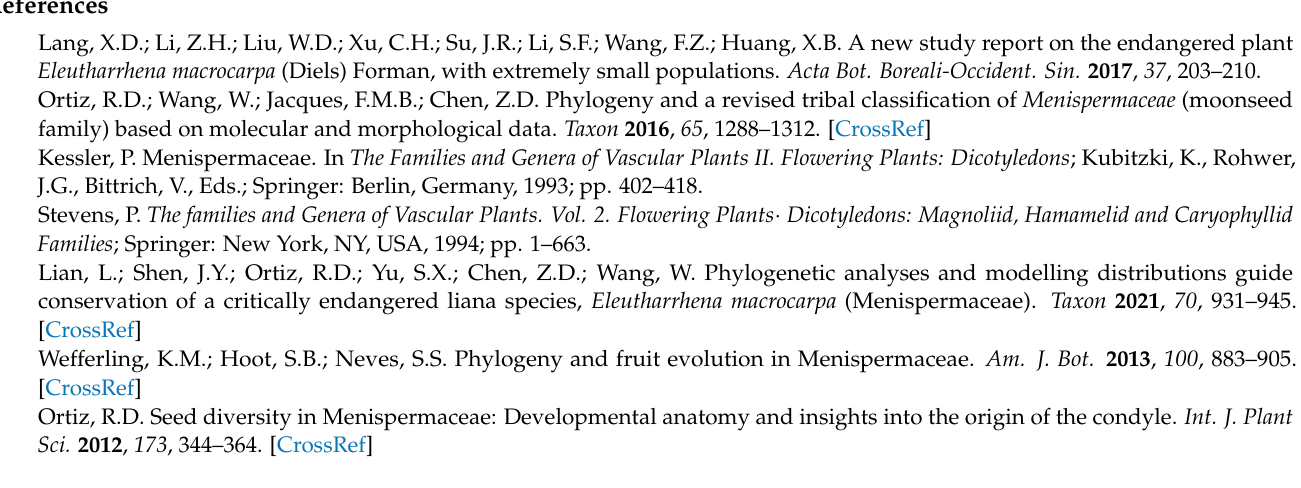
Figure A3. Mantel’s test between genetic distance and geographical distance correlation. Equation: Y = 0.0003 x + 0.1029, R 2 = 0.2299, p = 0.01.